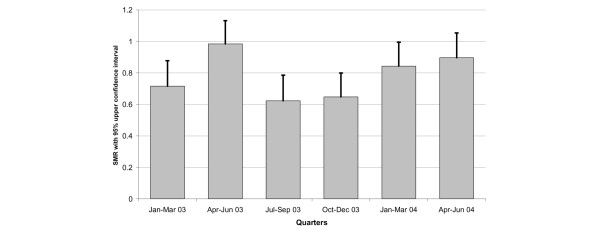
Standardised mortality ratios by quarter, with 95% confidence intervals. Probability of death estimated with UK APACHE, Royal Berkshire Hospital, 1 January 2003 to 30 June 2004